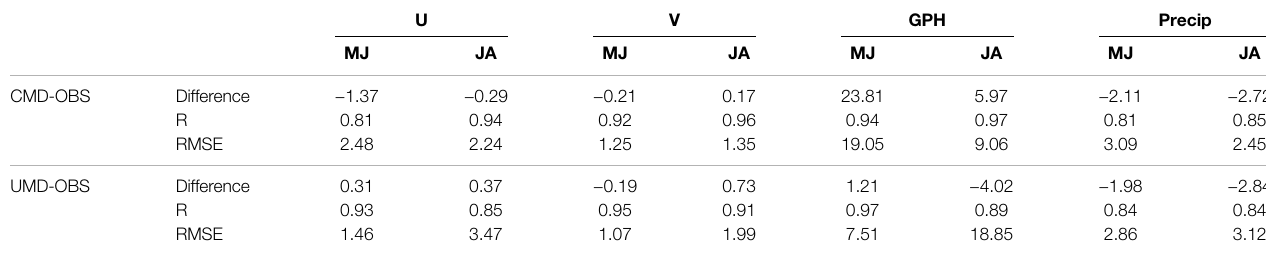
TABLE 2 | The mean differences, R (spatial pattern correlation) and RMSE (root mean squared error) between observed (OBS: MERRA − 2/GPCP) and simulated results (CMD and UMD) for 850 hPa U, V, GPH and precipitation of the region in Figures 4 , 5 (0 – 40 ° N, 30 – 90 ° E) during the early and the late monsoon season, respectively. U V GPH